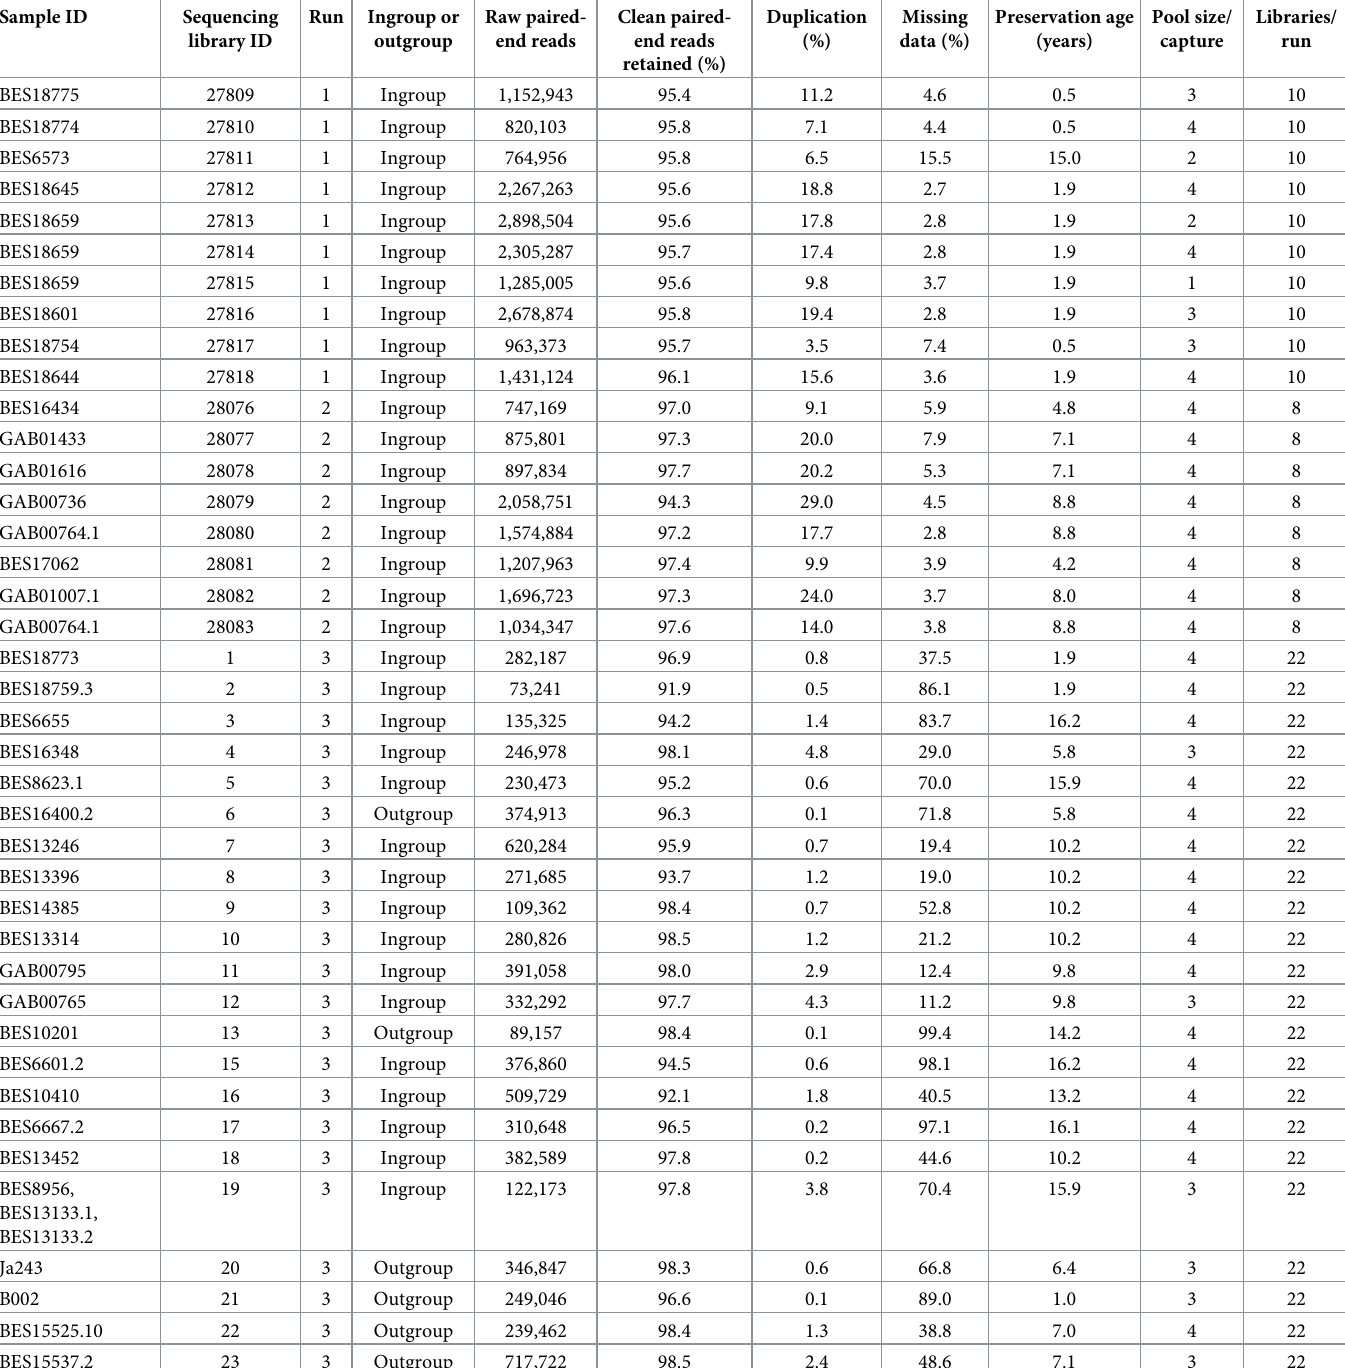
Table 2. Exon capture sample, mapping and sequencing run